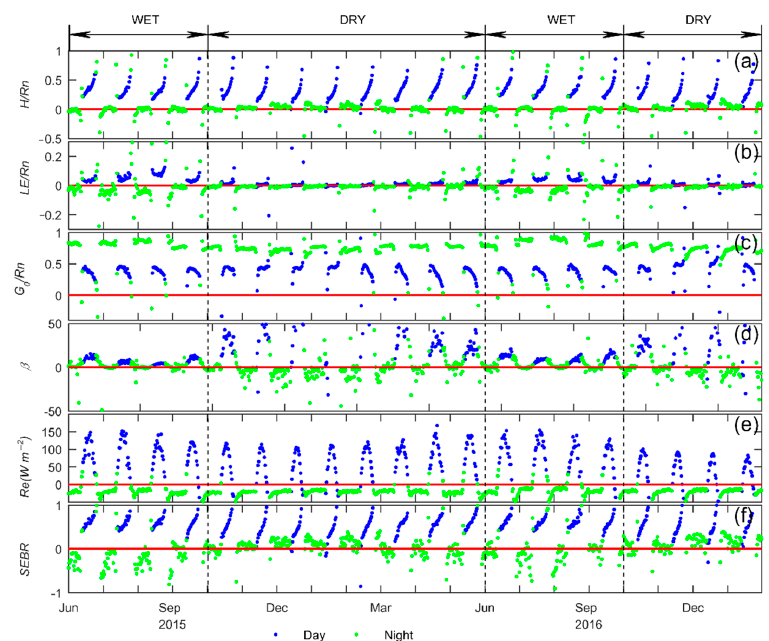
Figure 7. The monthly averaged diurnal variations of H / Rn , LE / Rn , G 0 / Rn , Bowen ratio ( β ), Re, and SEBR . Blue and green dots indicate daytime (10:00–19:00 local time) and nighttime (19:00–10:00 local time), respectively. Atmosphere 2020 , 11 , 260